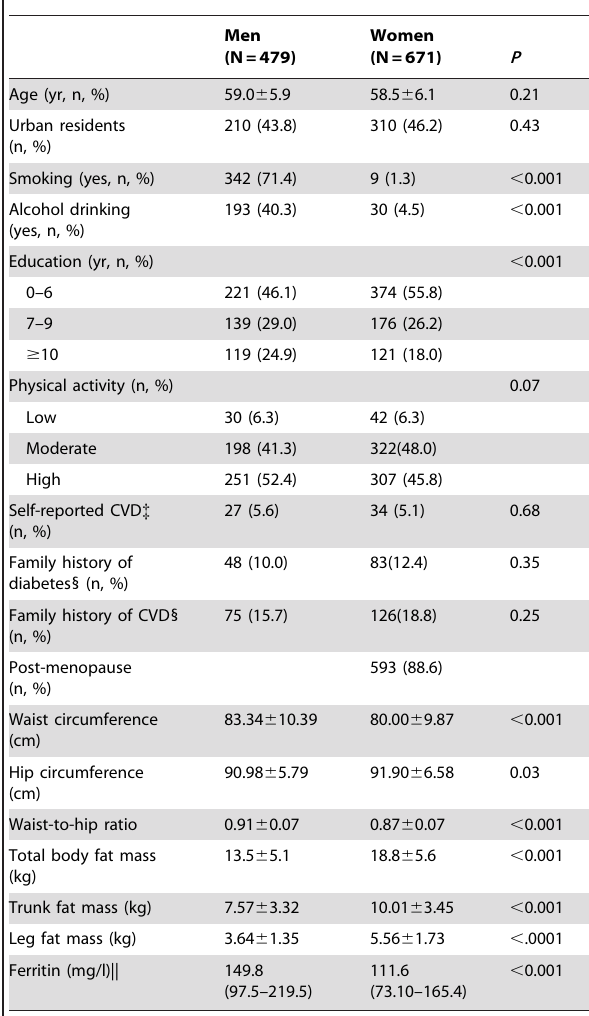
Table 1. Characteristics of study